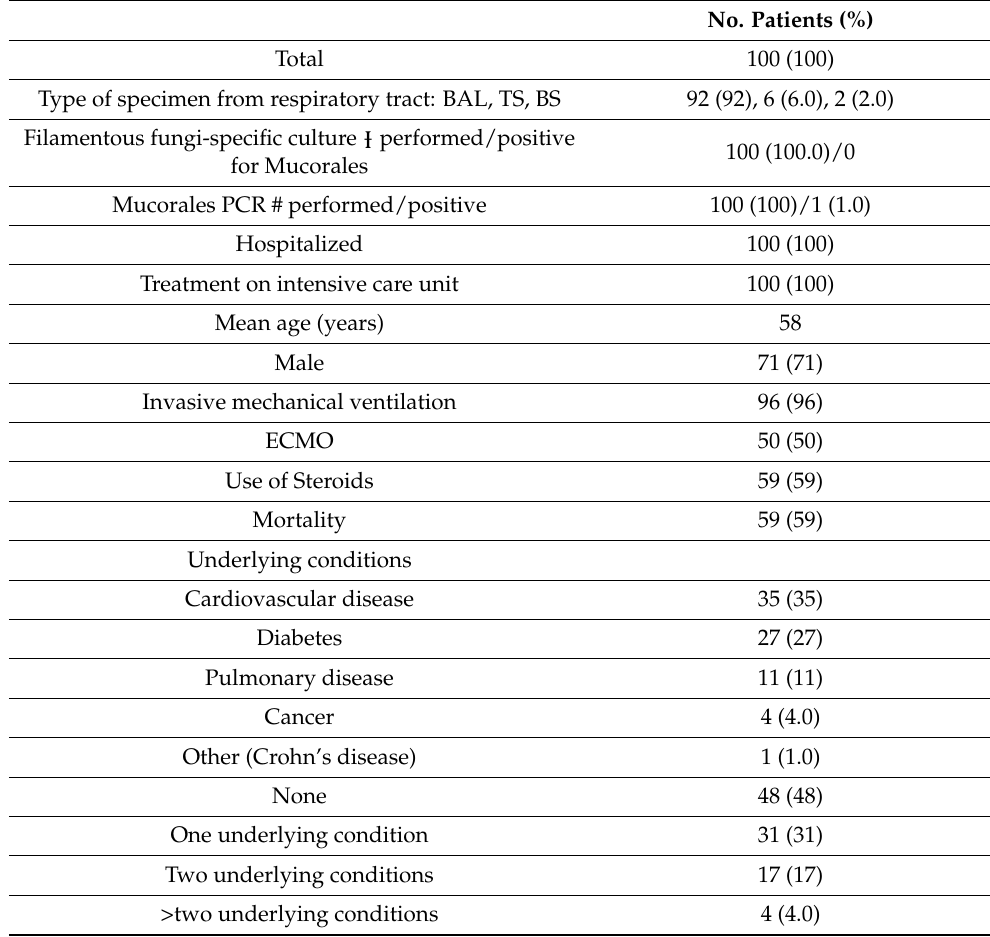
Table 1. Demographics and underlying conditions of patients with COVID-19 examined for Mucorales. corales.